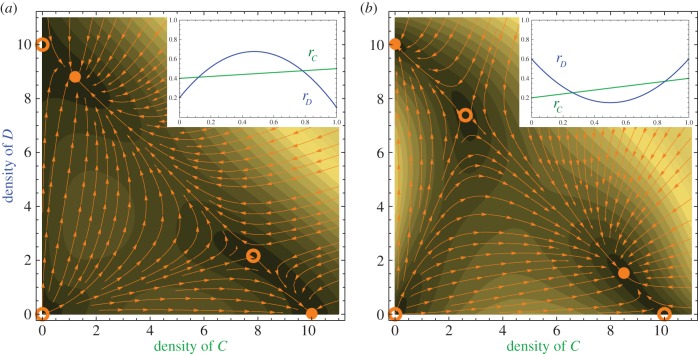
Population growth with quadratic growth functions (cf. equation (3.5)). Schematic phase trajectories near the steady states when frequency-dependent growth rate functions intersect twice. There is always a stable node () and a saddle point () in the first quadrant. The insets represent the frequency-dependent growth rates, in which the x-axis is the frequency of C. There are two general cases in which rC and rD intersect twice. (a) The quadratic growth rate has a maximum due to δ2 < 0 (rC = 0.4 + 0.1x, rD = 0.2 + 2x − 2.1x2). (b) The quadratic growth rate has a minimum due to δ2 > 0 (rC = 0.2 + 0.2x, rD = 0.6 − 1.8x + 1.8x2).